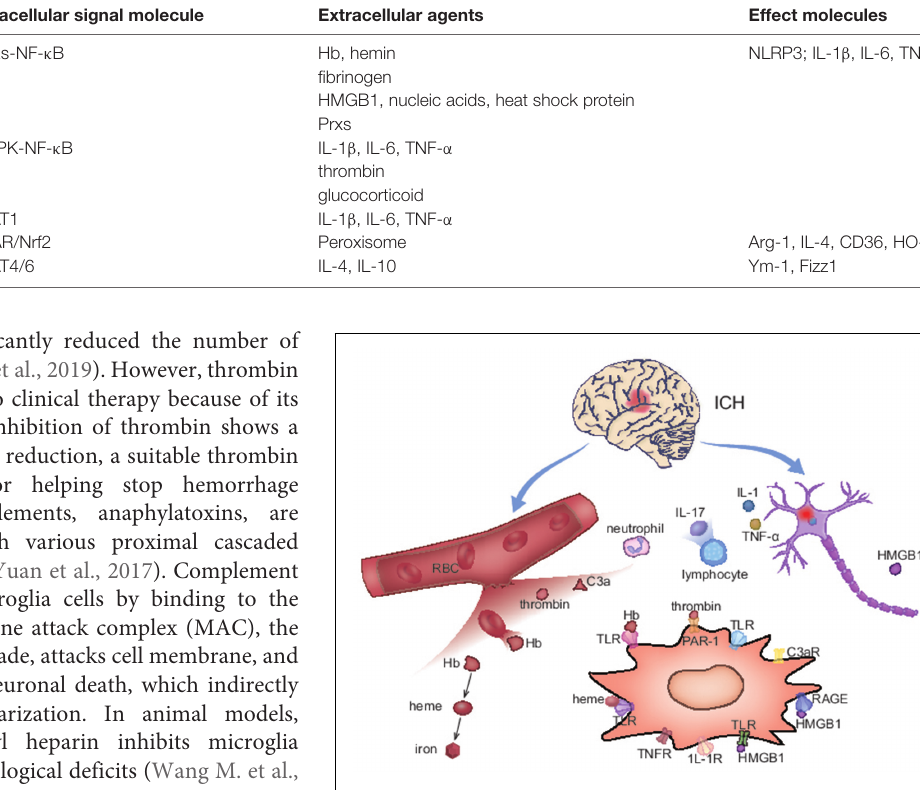
FIGURE 3 | The activation mechanism of M1 microglia after ICH. In ICH acute phase, M1 microglia are activated on account of the blood composition and neuron primary damage. Meanwhile, microglia up-express corresponding receptors for